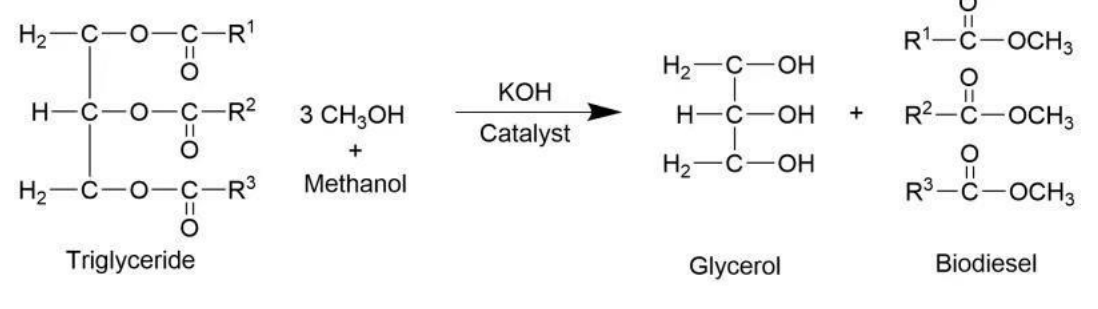
Figure 1. Transesterification reaction.